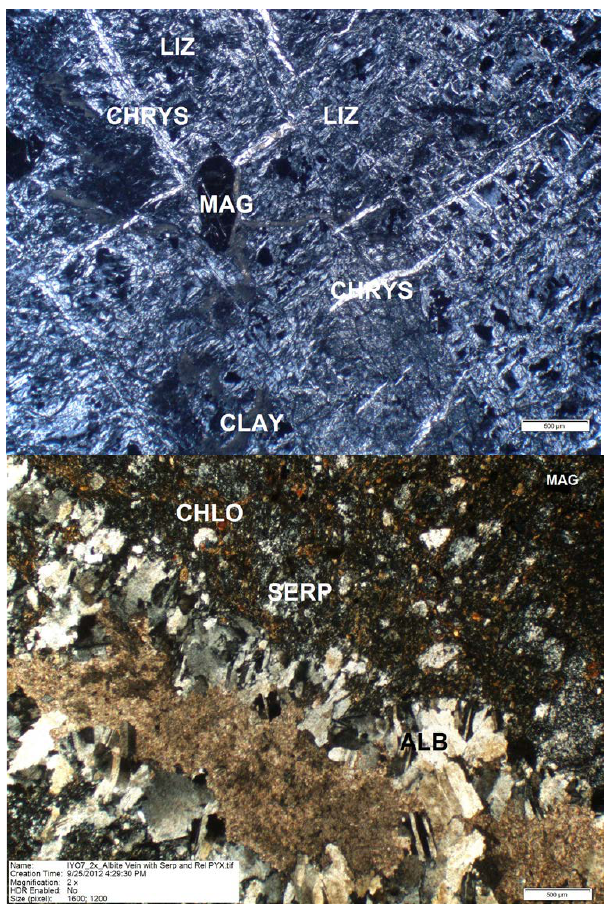
Figure 6. Representative thin sections. Top: CROMO2 at 41.15m depth (2X). This thin section confirms the results from the XRD, showing lizardite as the dominant phase, the mesh-like white and blue matrix, with white veinlets of chrysotile and scattered black blebs of magnetite. Some clay minerals are present as well as opaque brown streaks. Bottom: CROMO1 at 31m depth (2X). This thin section image was obtained with crossed polarizers applied. Al- bite crystals are the white and black twinned crystals that appear to extrude diagonally from the SE corner to the NW corner. Serpentine is present as black and white mottled mineral in the N and NE por- tion of the slide. Chlorite, another clay mineral shows up as slightly green-hued under cross-polarized light and is pervasive in the thin